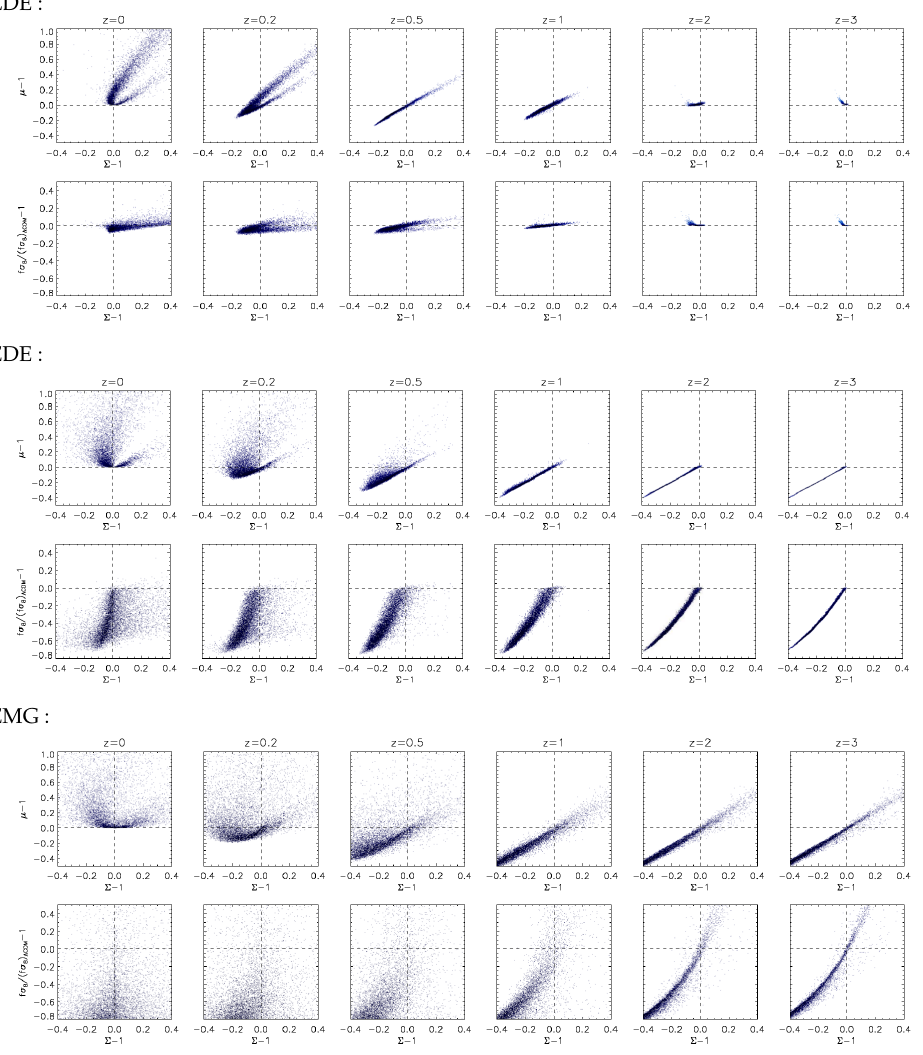
Figure 1. We display the correlations µ - Σ and f σ 8 - Σ for several redshifts z = 0, 0.2, 0.5, 1, 2, 3 . The first two rows correspond to a generation of 10 4 viable EFT models in the LDE scenario, the middle two rows 10 4 models in the EDE scenario and the bottom two rows 10 4 models in the EMG scenario. All the models bear c T ( t 0 ) = c . In each plot, the Λ CDM prediction corresponds to the intersection of the two dashed lines and the gray/blue scale highlights the density of points.